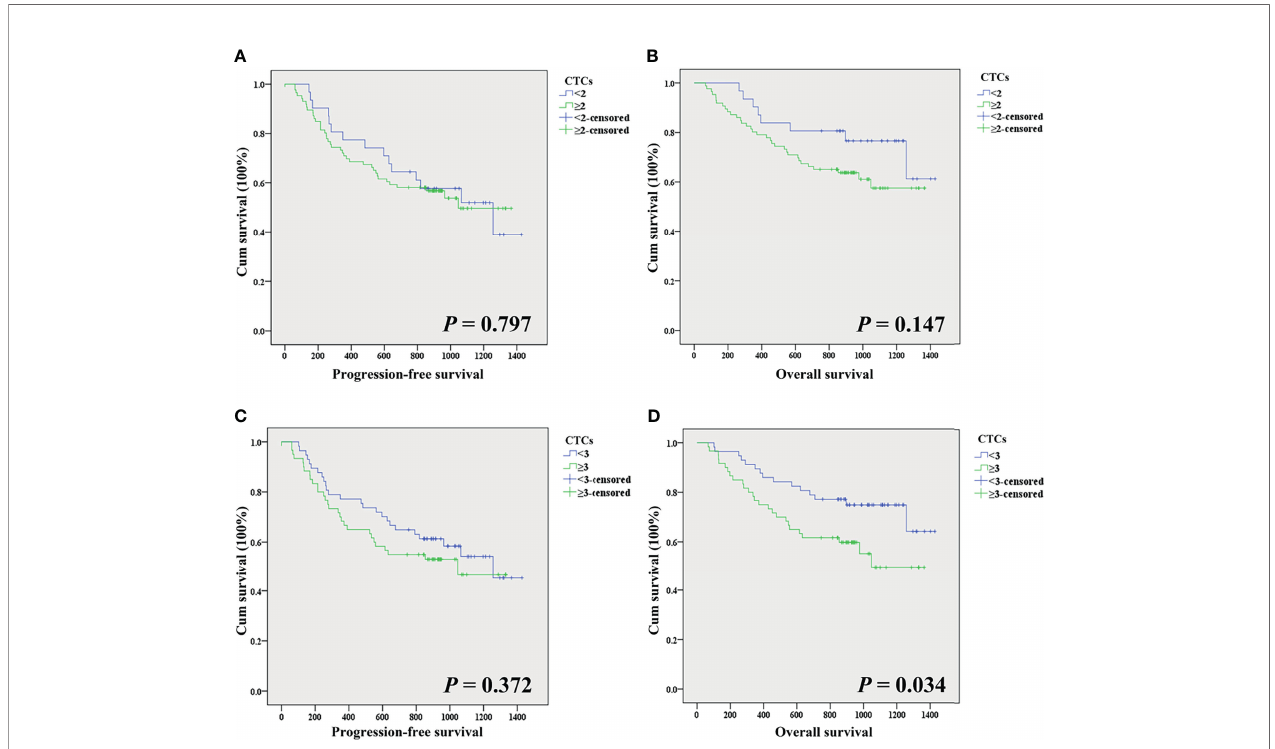
FIGURE 3 | (A) Comparison of the progression-free survival time of patients with CTCs <2 and CTCs ≥ 2. (B) Comparison of the overall survival time of patients with CTCs <2 and CTCs ≥ 2. (C) Comparison of the progression-free survival time of patients with CTCs <3 and CTCs ≥ 3. (D) Comparison of the overall survival time of patients with CTCs <3 and CTCs ≥